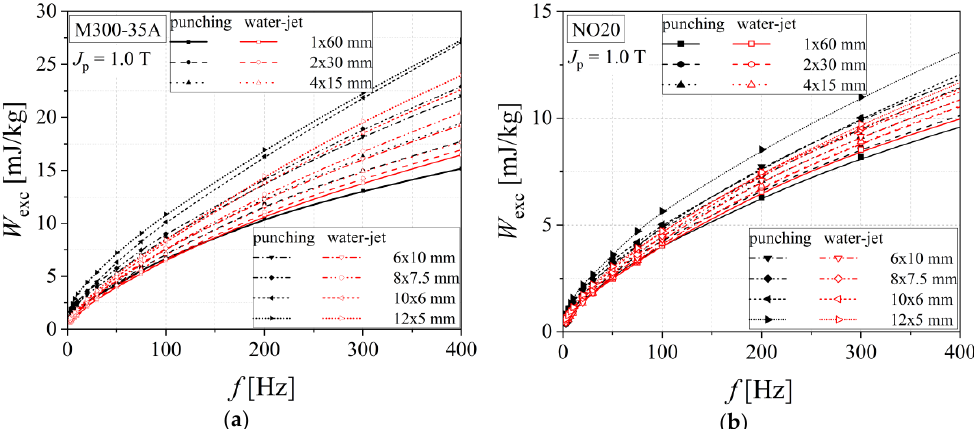
Figure 15. Excess energy loss versus frequency dependencies of electrical steel grade M300-35A ( a ) and NO20 ( b ), in the case of two cutting technologies.